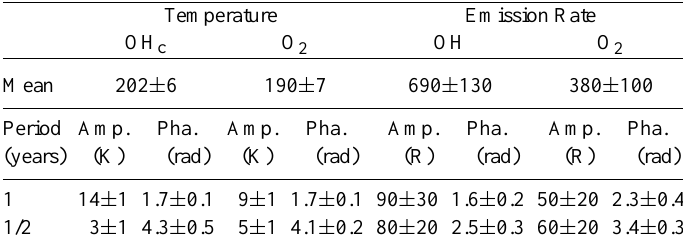
Table 2. Annual and semiannual variations Temperature Emission Rate OH c O 2 OH O 2 Mean 202 ± 6 190 ± 7 690 ± 130 380 ± 100 Period Amp. Pha. Amp. Pha. Amp. Pha. Amp. Pha. (years) (K) (rad) (K) (rad) (R) (rad) (R)